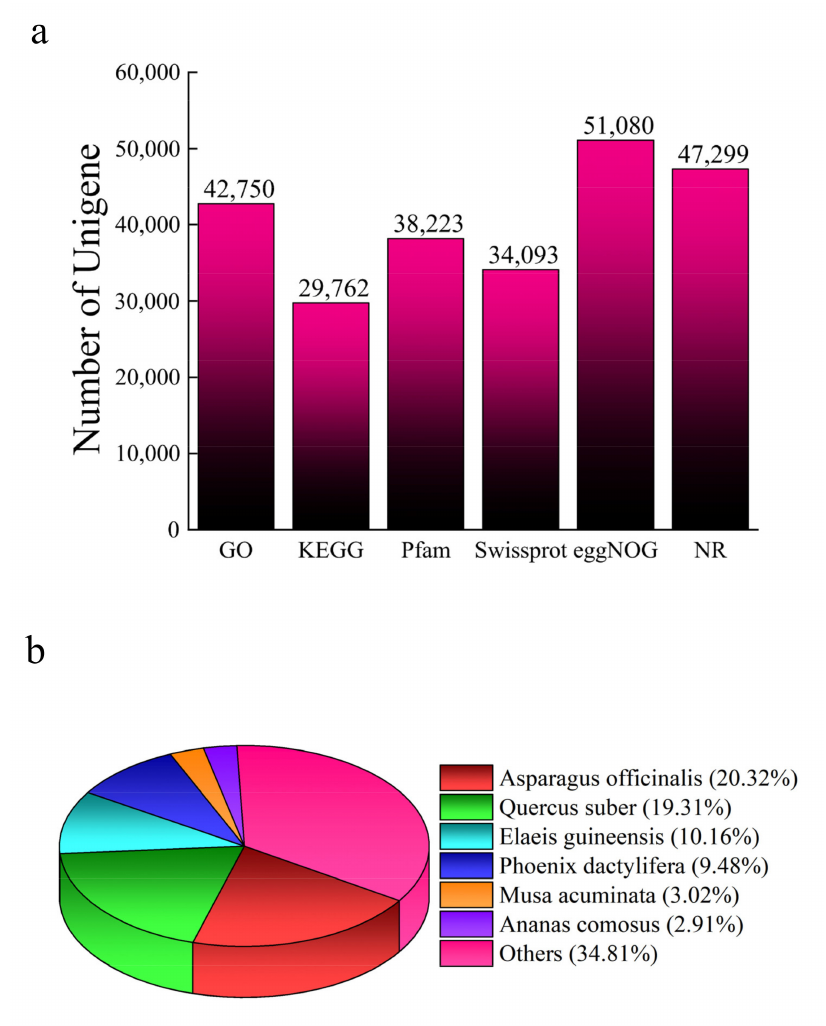
Figure 3. Unigenes annotated in different databases ( a ) and distributed into different species ( b ).